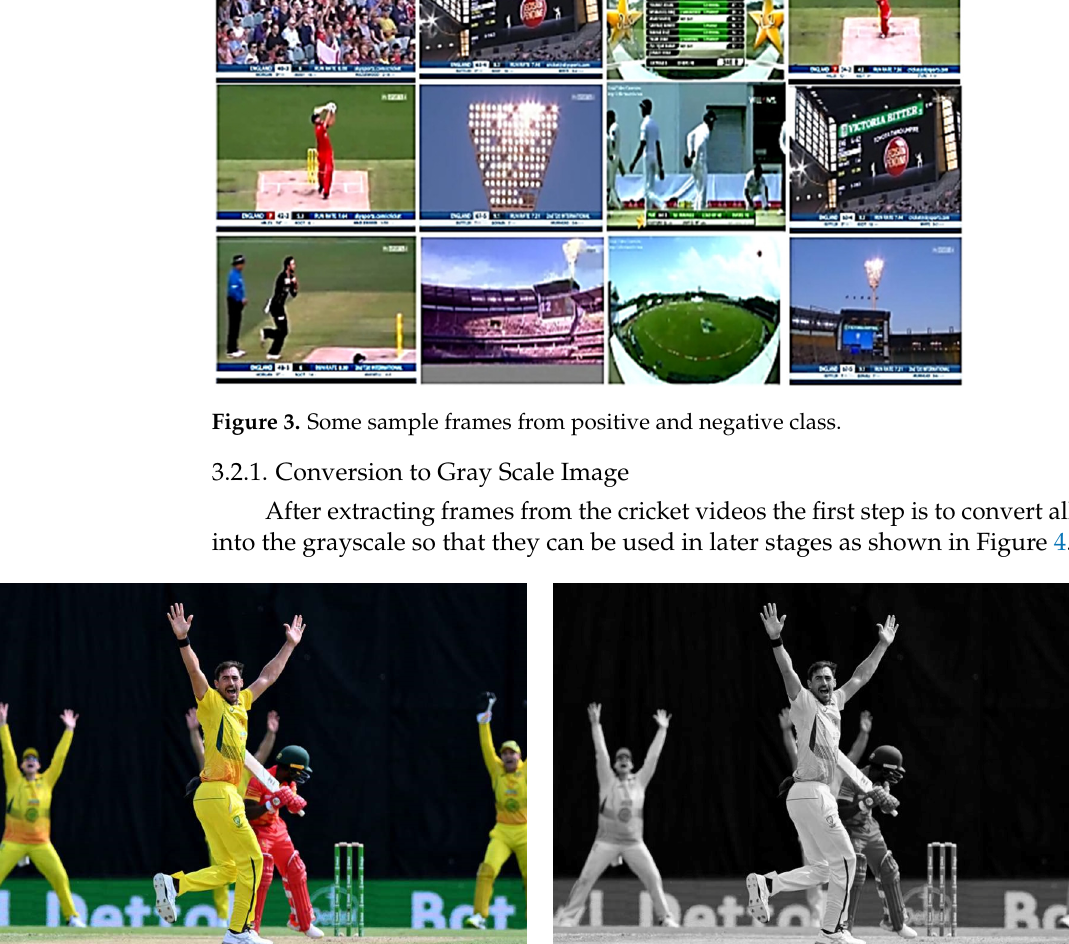
Figure 2. Extraction of Frames based OCR.